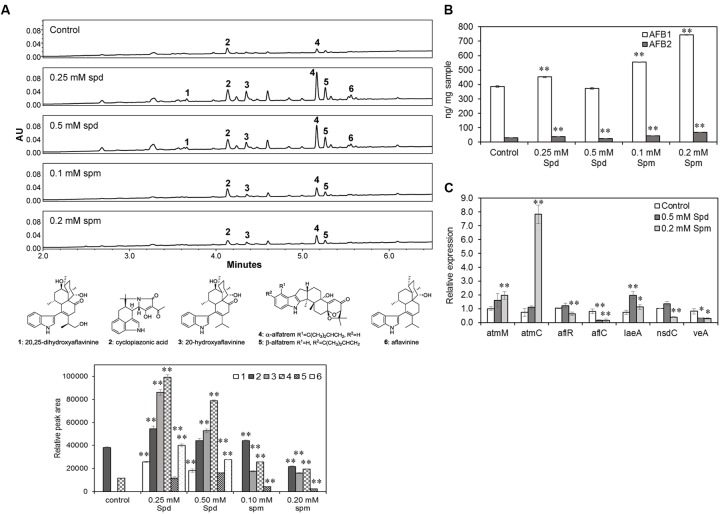
The effects of Spermidine and Spermine (Spm) on secondary metabolite (SM) production and related gene expression. (A) Production of indole diterpene SMs (chromatograms at λ = 254 nm) in A. flavus AF70 WT strain grown on solid Czapek’s medium (with ammonium sulfate) supplemented with different concentrations of Spd and spermine along with control (no PAs) grown for 14 days in the dark at 30°C. Aflatoxins were not detected in any of these samples as Czapek’s medium is not conducive for aflatoxin production; (B) Production of aflatoxins in A. flavus AF70 WT strain grown on solid A&M medium supplemented with different concentrations of Spd and spermine along with control (no PAs) grown for 7 days in the dark at 30°C; (C) Effect of exogenous supply of Spd and Spm on the expression of secondary metabolite related genes, atmM, atmC, aflR, aflC, cpaA, and global regulatory genes, laeA, nsdC, and veA in A. flavus AF70 WT strain. The samples were grown in CZ liquid medium (static culture) for 5 days in the dark at 30°C. Data are Mean ± SE of three replicates (∗∗P ≤ 0.05 and ∗P ≤ 0.10 between control and treatment, Student’s t-test).